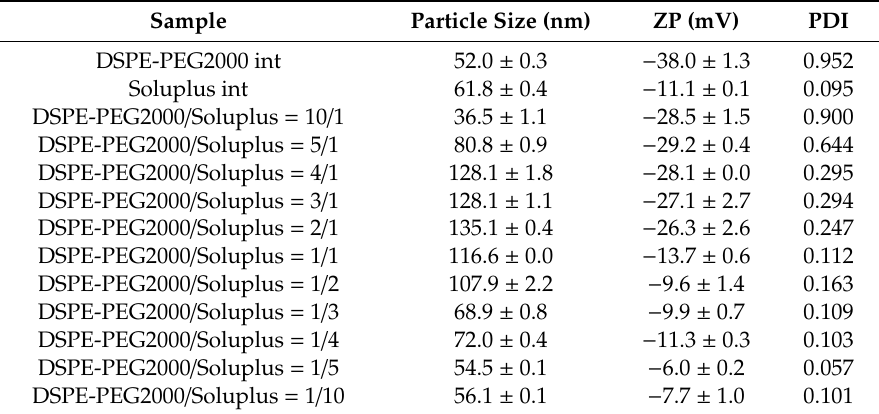
Table 1. Particle size and zeta potential (ZP) of